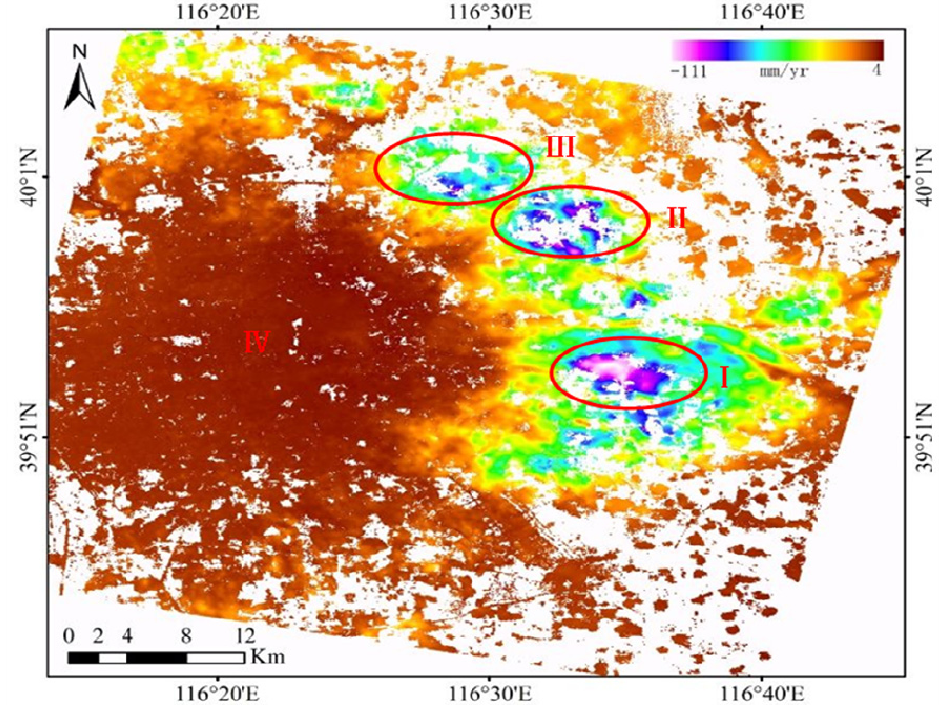
Figure 3. Average displacement velocity map over the study area derived by SBAS technique. The red ellipses indicate the sedimentation funnel areas (e.g., I, II, III). Zone IV is a stable settlement